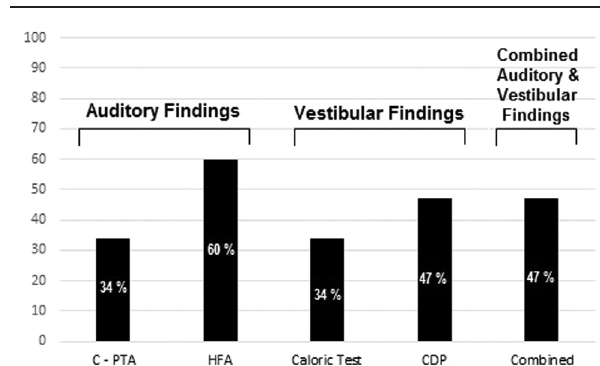
Findings of audiovestibular function tests in the study group. C-PTA, conventional pure-tone audiometry; CDP, computerized dynamic posturography; HFA, high-frequency